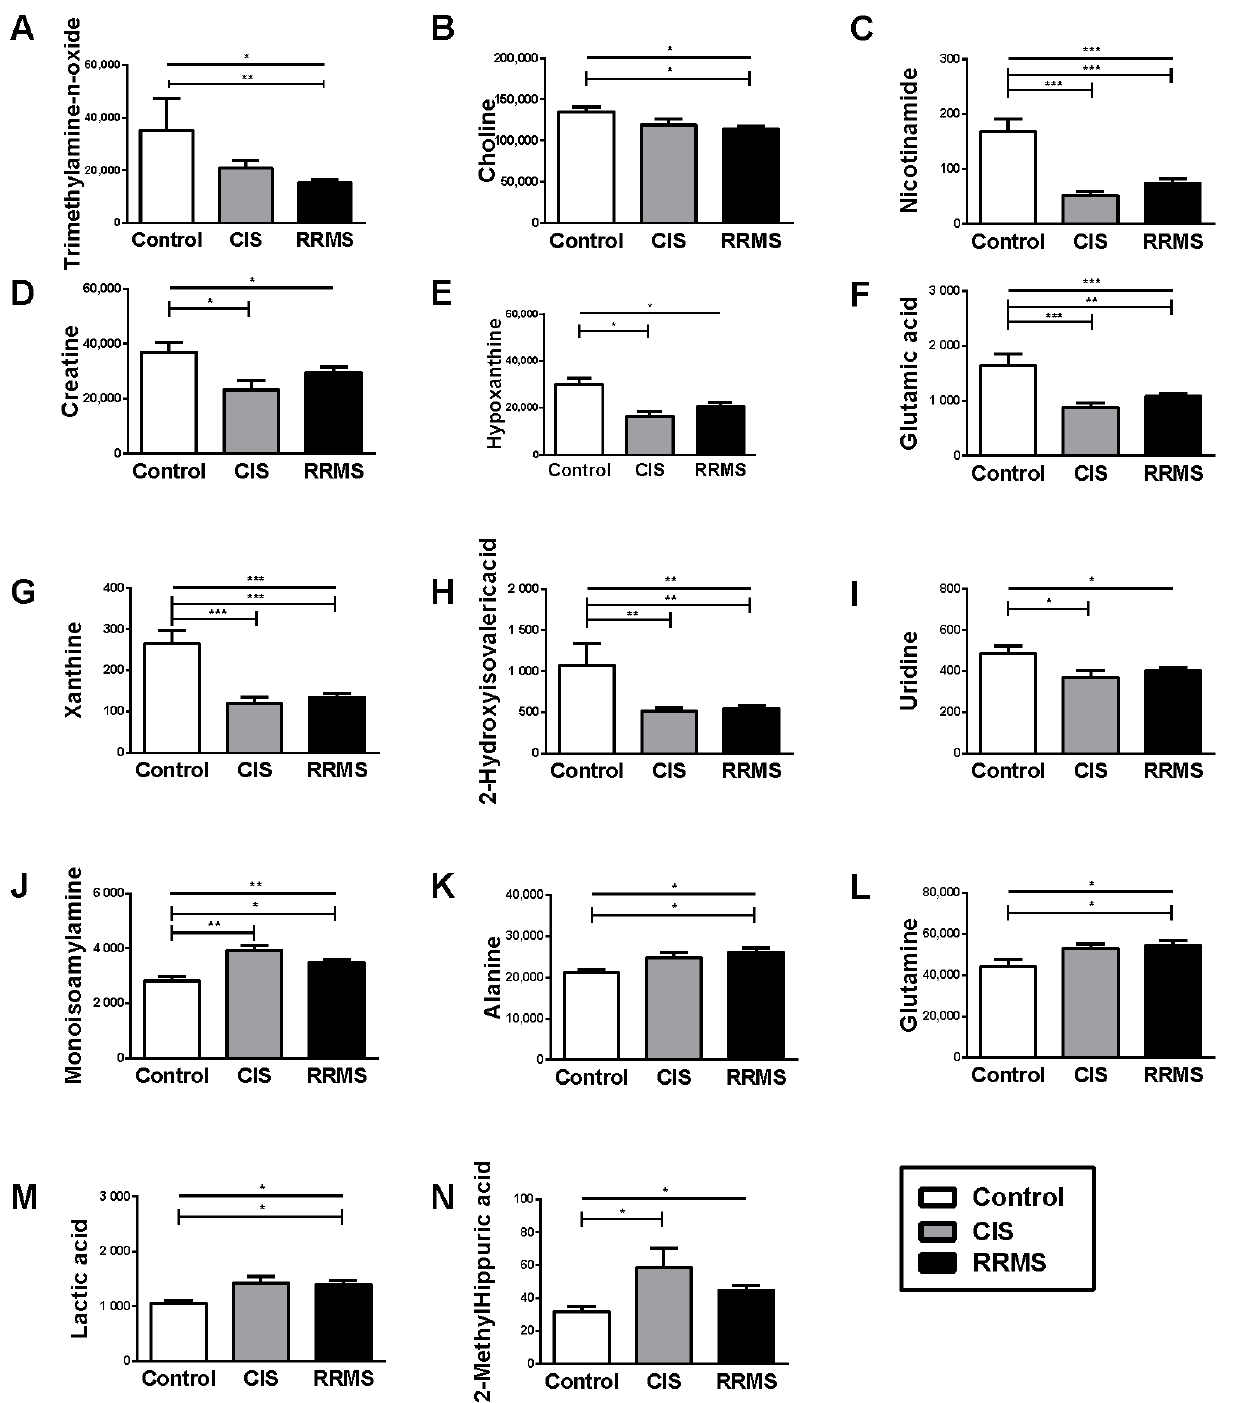
Figure 2. Variation of statistically significant metabolomics’ compounds in each of the studied group. ( A ) trimethylamine-n-oxide; ( B ) choline; ( C ) nicotinamide; ( D ) creatine; ( E ) hypoxanthine; ( F ) glutamic acid; ( G ) xanthine; ( H ) 2-Hydroxyisovalericacid; ( I ) uridine; ( J ) monoisoamylamine; ( K ) alanine; ( L ) glutamine; ( M ) lactic acid; ( N ) 2-MethylHippuric acid. Bars ± error bars indicate mean ± standard error of mean. Line with open edges indicates overall comparison among the three groups. Lines with vertical edges indicate post-hoc comparisons. CIS: Clinically Isolated Syndrome; RRMS: Relapsing-Remitting Multiple Sclerosis. * p < 0.05; ** p < 0.01; *** p < 0.001.